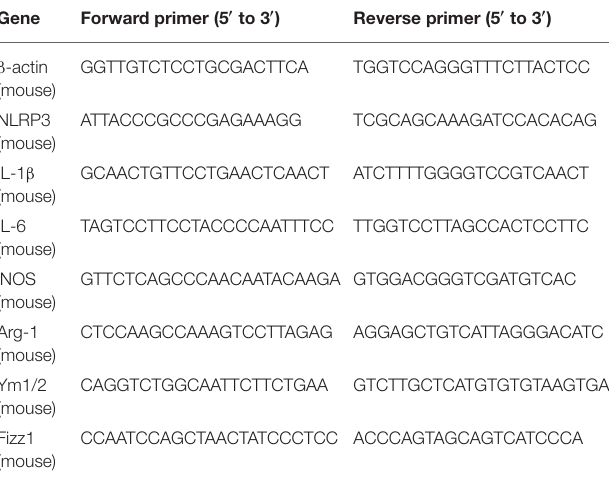
TABLE 1 | Sequences of target genes for real-time